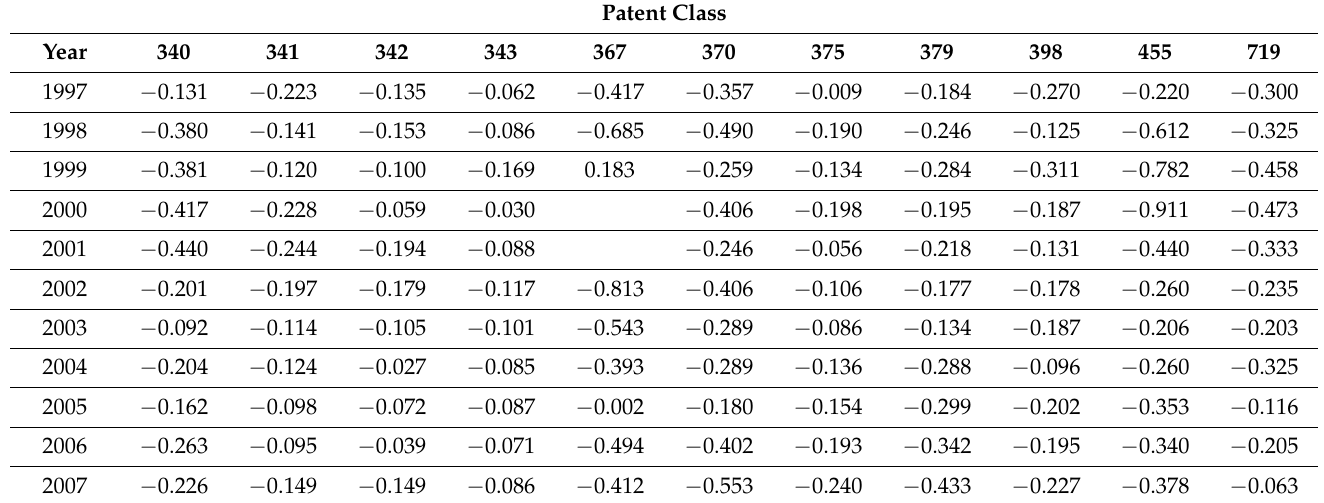
Table 5. Further descriptive statistics for follow the leader when all firms have different leaders